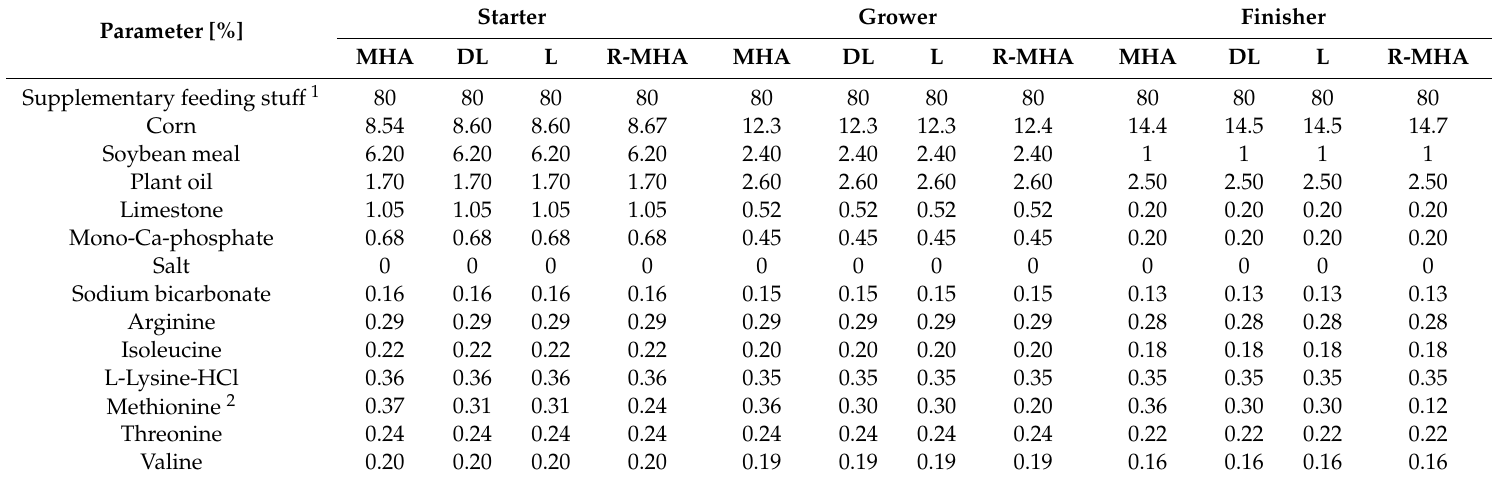
Table A1. Ingredient composition of the diets during the whole experimental period.